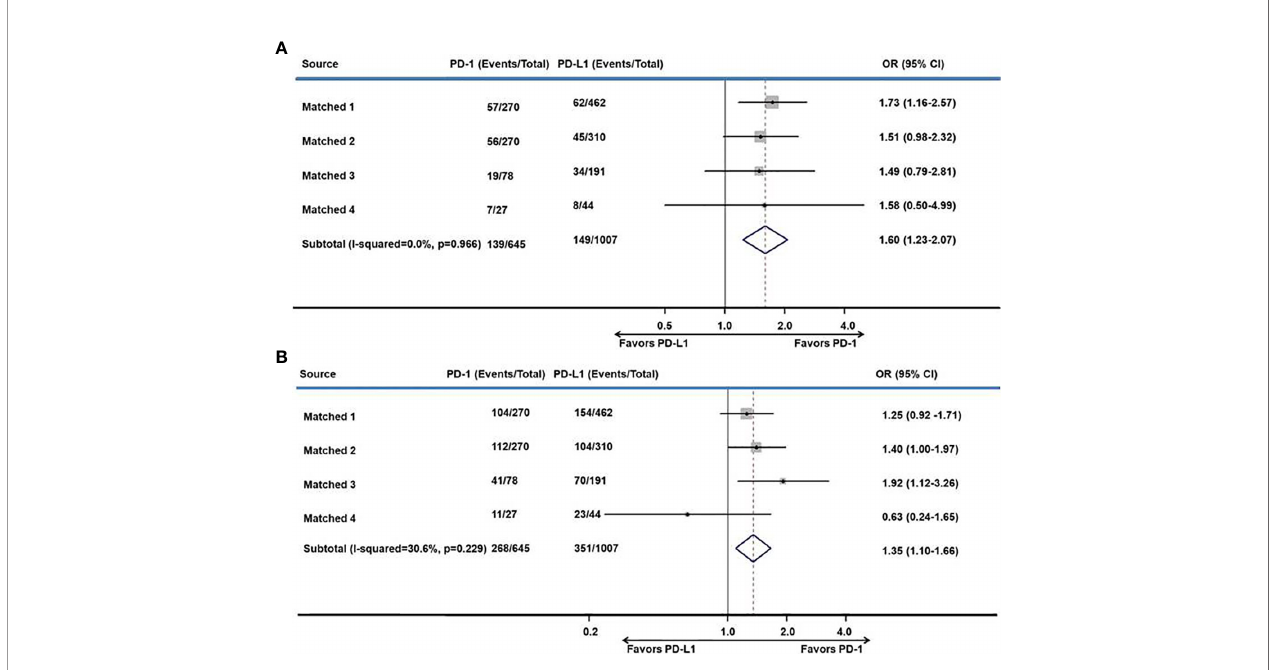
FIGURE 3 | Meta-analysis of pooled odds ratios of a tumor response to anti – PD-1 versus anti – PD-L1 therapy. (A) ORR, (B)